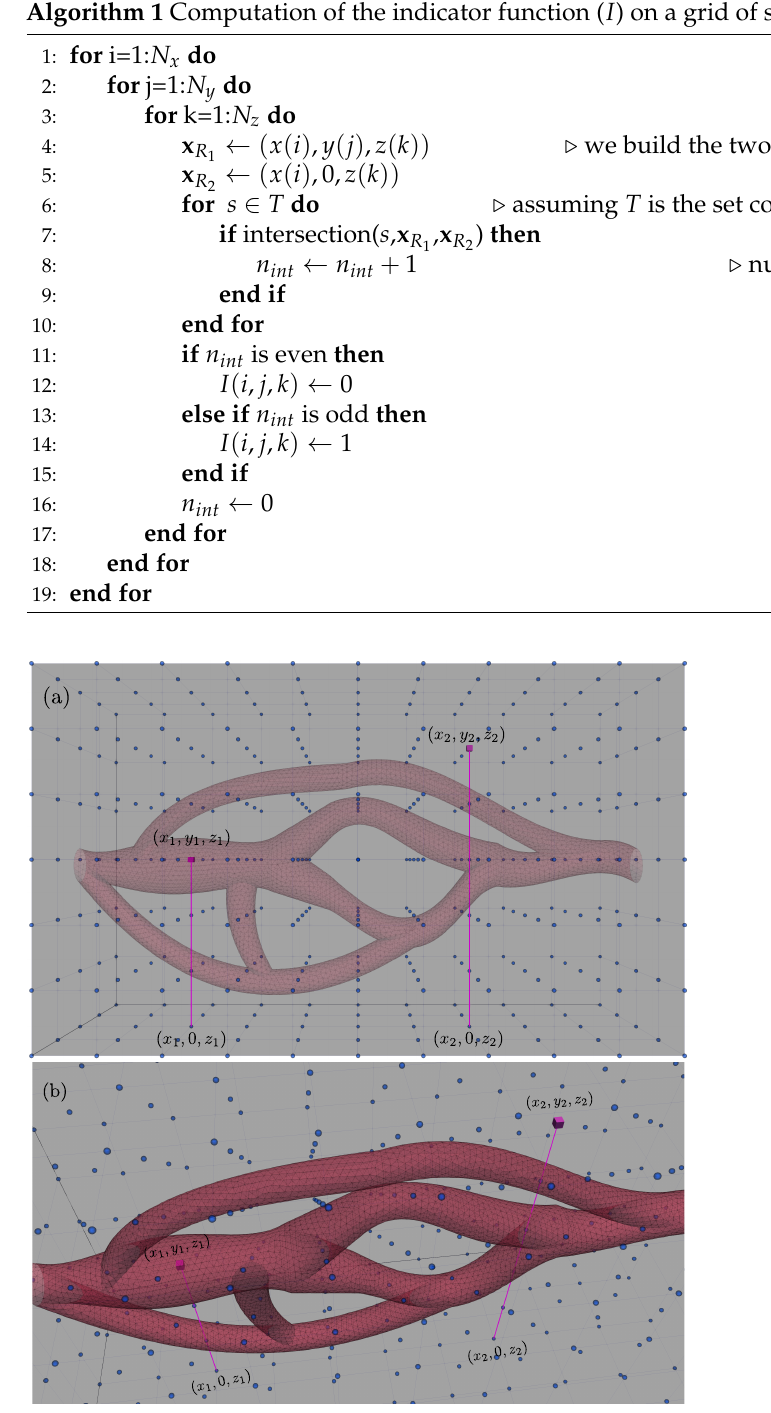
Figure 3. Ray-tracing approach employed for two nodes located at ( x 1 , y 1 , z 1 ) and ( x 2 , y 2 , z 2 ) : ( a ) front and ( b ) top-left views of the blood